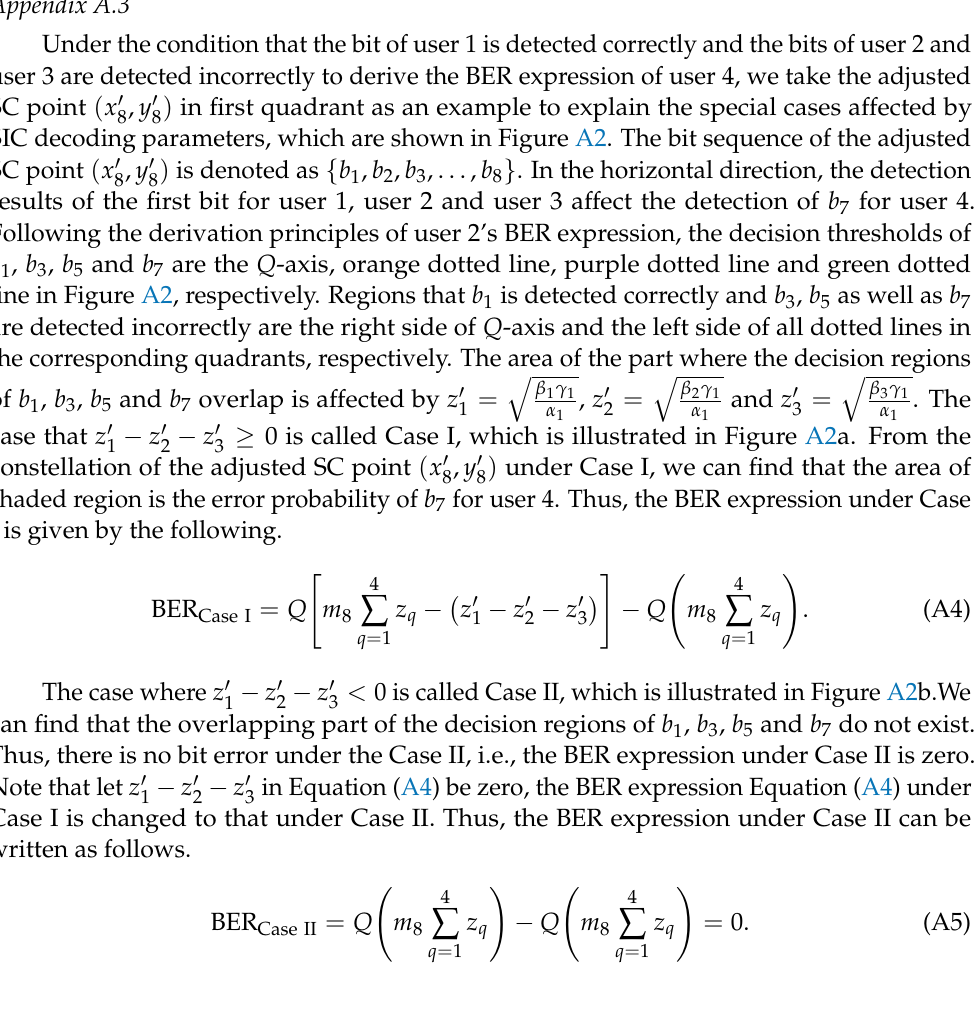
in K 2, x (cid:48) 2 K − 1